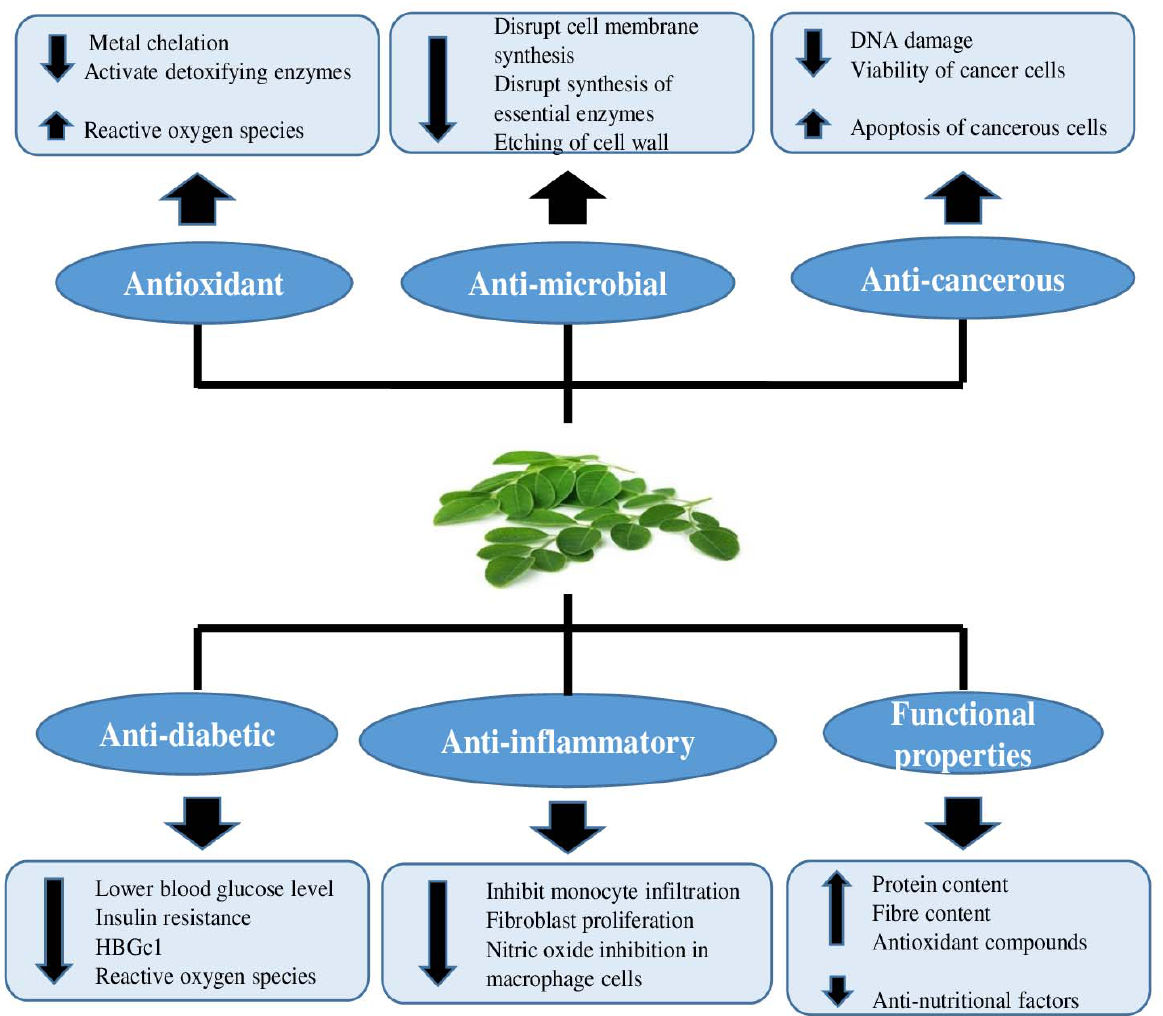
Figure 2. Health benefits of Moringa oleifera leaves based on their inherent properties.